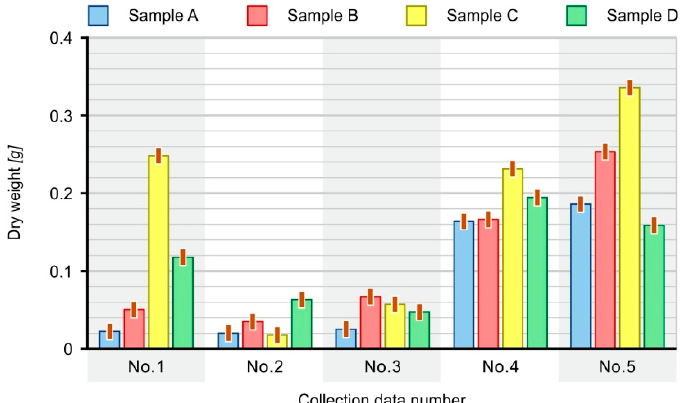
Figure 10. Average dry matter of biofilm on composites in successive dates (numbers) of sampling .